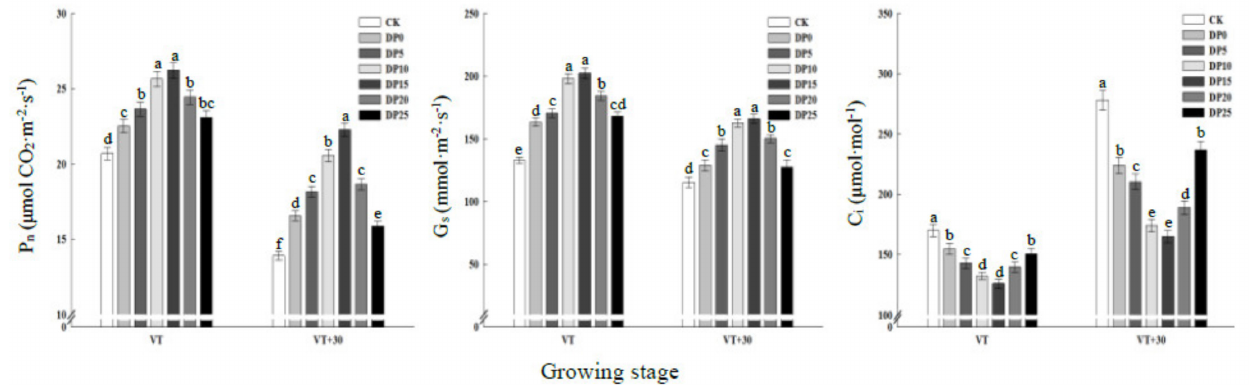
Figure 5. Effects of different basal application depths of controlled-release urea on photosynthetic characteristics of panicle leaf. CK: no fertilizer; DP0: surface application; DP5: fertilization depth 5 cm; DP10: fertilization depth 10 cm; DP15: fertilization depth 15 cm; DP20: fertilization depth 20 cm; DP25: fertilization depth 25 cm. Thin vertical bars are standard errors ( n = 15). Different letters in each column indicate significant differences at p < 0.05